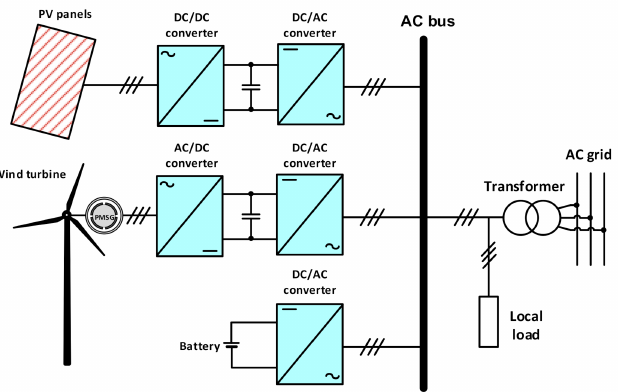
Figure 2. Scheme of grid-connected hybrid renewable energy system (HRES) with common AC bus.